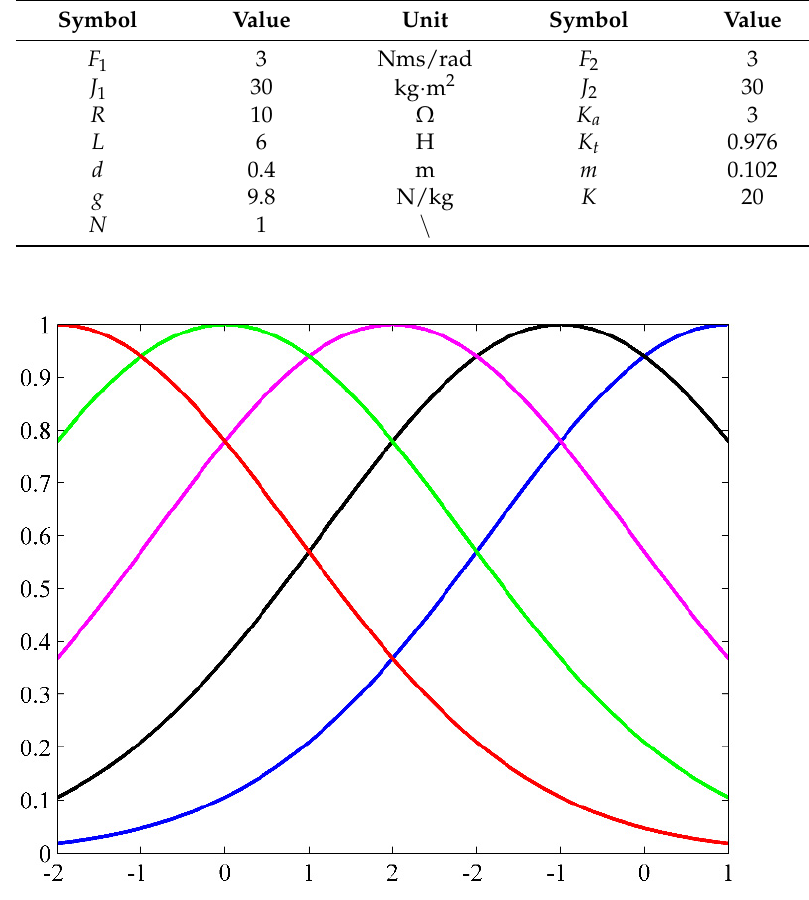
Figure 1. The fuzzy rules.